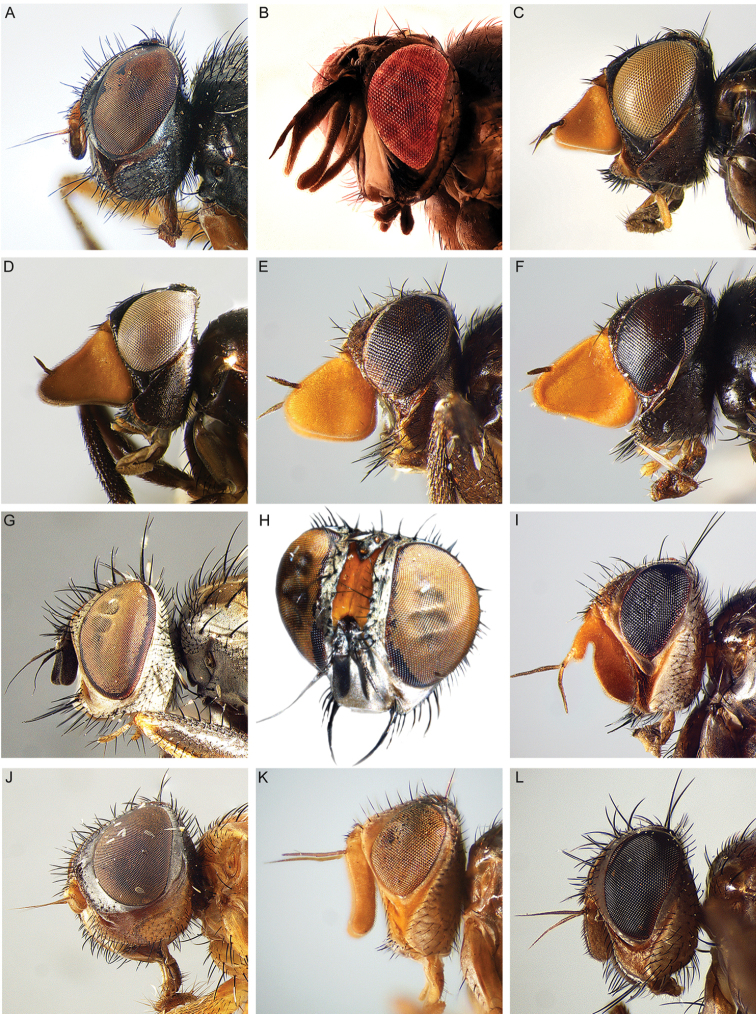
Rhinophoridae, head in lateral view. AApomorphyto
inbio ♂ (Costa Rica) [holotype] BAporeomyia sp. (Malaysia, Sabah) CAxinia
arenaria ♂ (Australia) DAxinia
brevispica ♂ (Australia) EAxinia
lucaris ♂ (Australia) FAxinia
zentae ♂ (Australia) G, HAzaisia sp. ♂ (Portugal, Madeira) G lateral view, H dorsolateral view IBezzimyia
bisecta ♂ (Costa Rica) JBaniassa
fascipennis ♀ (Israel) [paratype] KBixinia
collessi ♂ (Australia) [paratype] LMalayia
fuscinervis ♀ (Malaysia, Malay Peninsula).